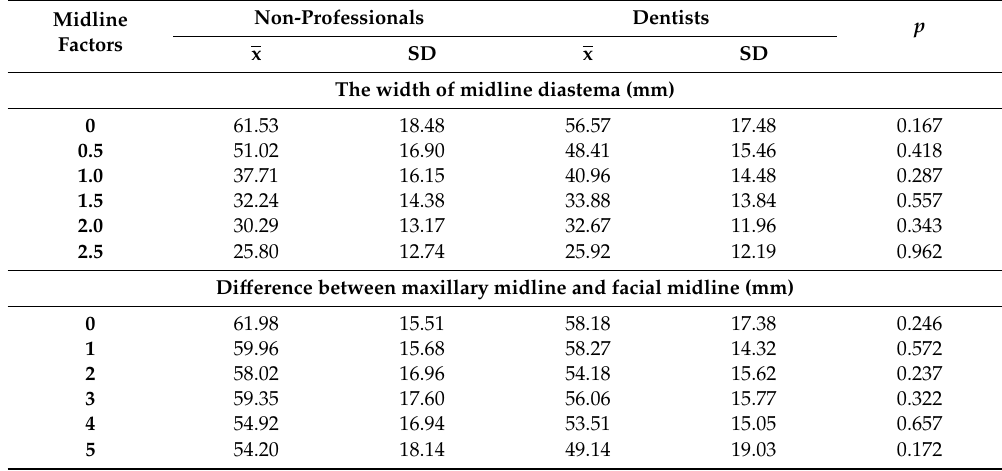
Table 3. Perceptions of dentists and non-professionals towards some midline factors. Non-Professionals Midline Factors